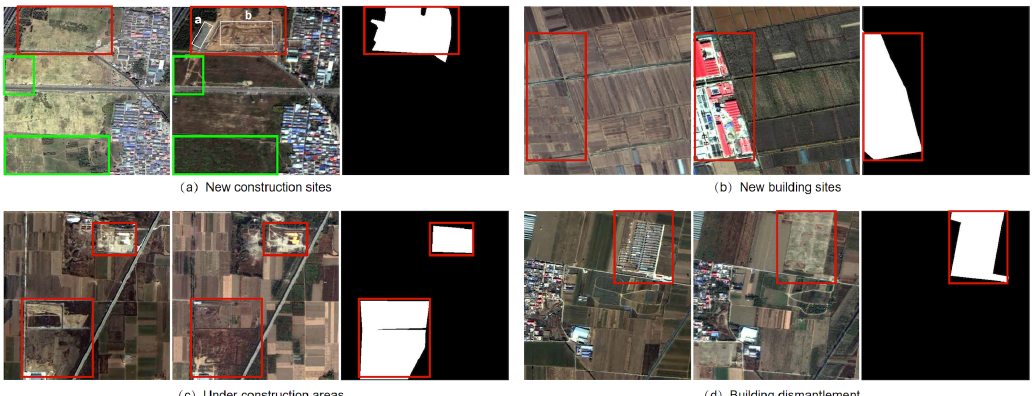
Figure 1. The illustration of the change detection problem. The images of each sub-figure are corresponding to images at t 1 and t 2 and the given change label mask. ( a – d ) are the examples of four different kinds of urban construction-related changes in our dataset. The red boxes bound the urban construction-related change areas and the green boxes mark the change areas we do not